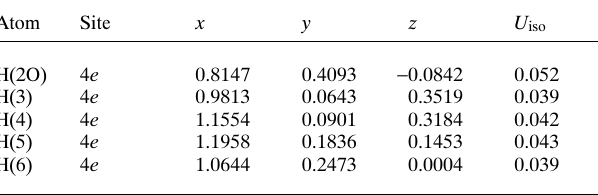
Table 2. Atomic coordinates and displacement parameters (in Å 2 )